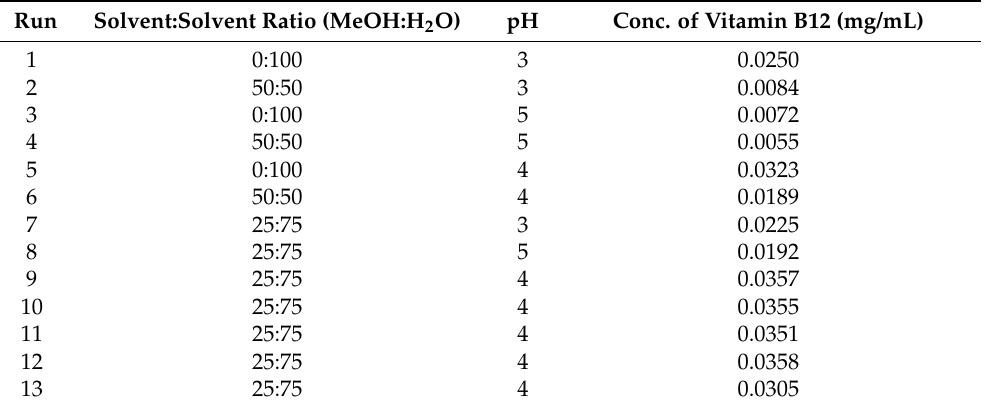
Table 1. Optimised design layout of CCD for the extraction of vitamin B12 from the U. lactuca oven-dried samples utilising the UAE technique.